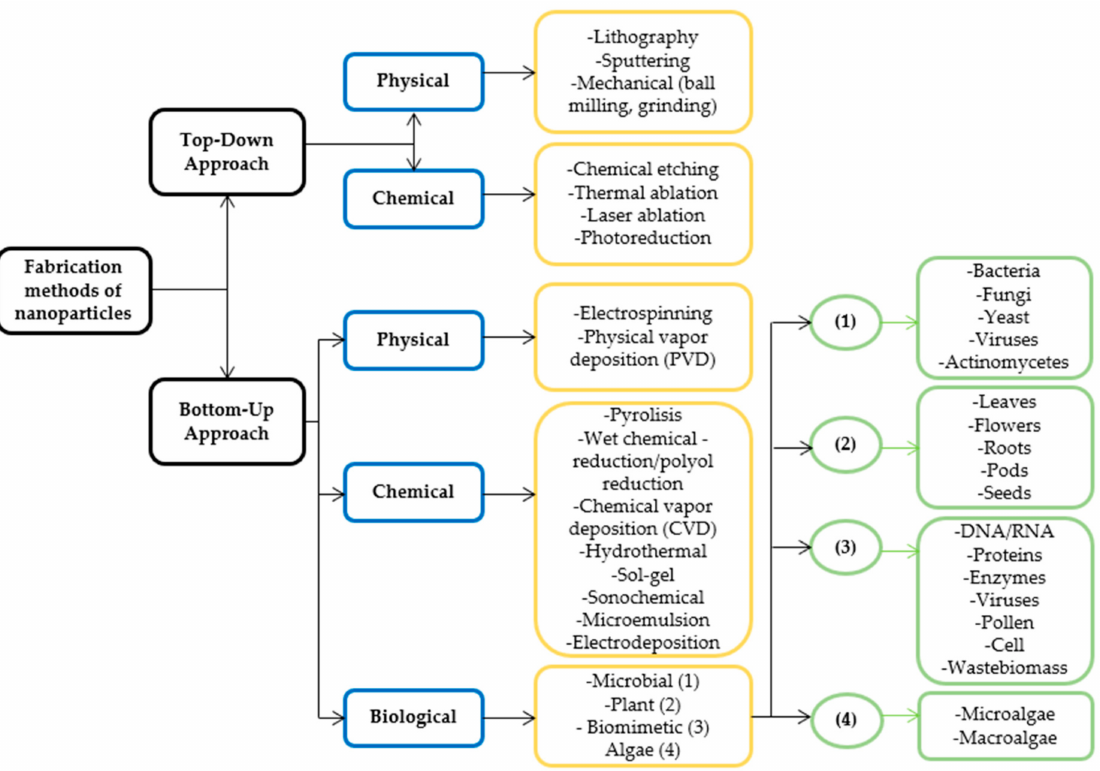
Figure 2. Top-Down and Bottom-Up approaches for synthesizing nanoparticles, (1) Microbial; (2) Plant; (3) Biomimetic; (4) Algae. Elaboration from Ref.